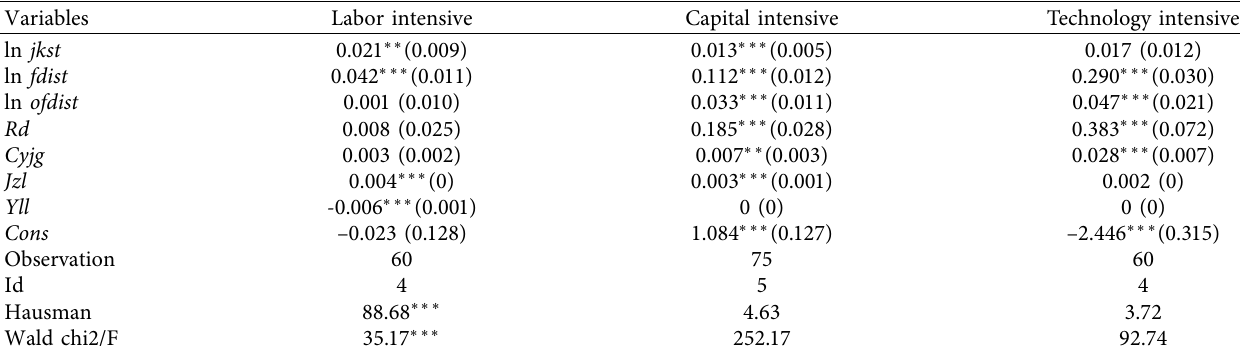
Table 5: Estimated results of manufacturing